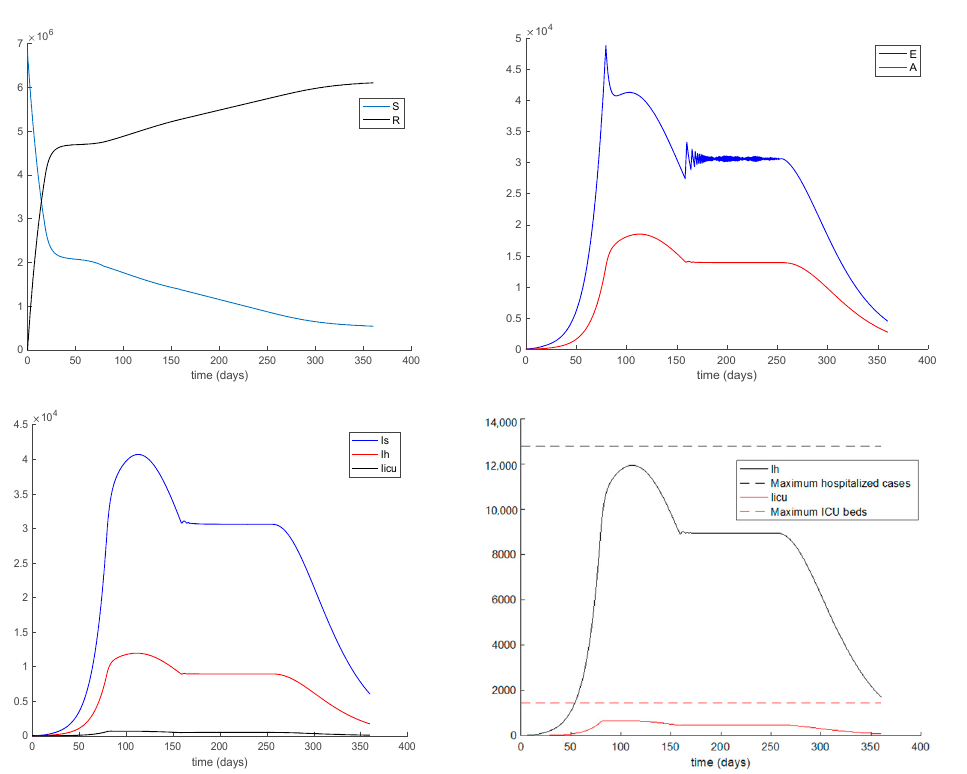
Figure 10. Control actions when Programme 6 is employed. Algorithms 2020 , 13 , x FOR PEER REVIEW